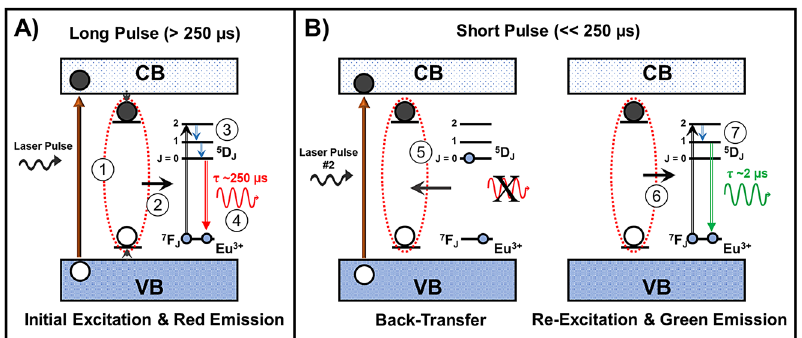
Figure 8: The basic principle of the re-excitation of Eu 3 + : (A) carriers are trapped at a localized defect (1), energy is transferred to the Eu 3 +